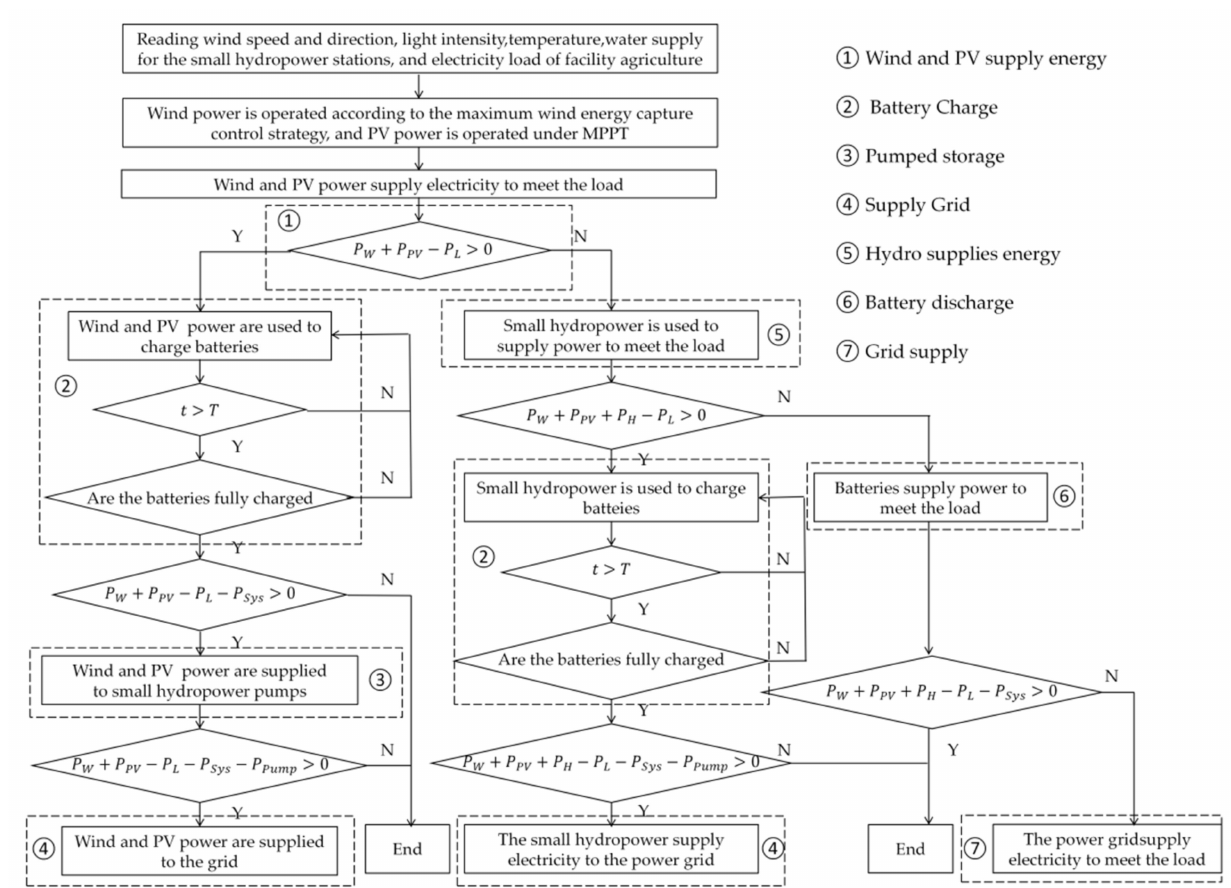
Figure 3. Flow chart of the hybrid system operation